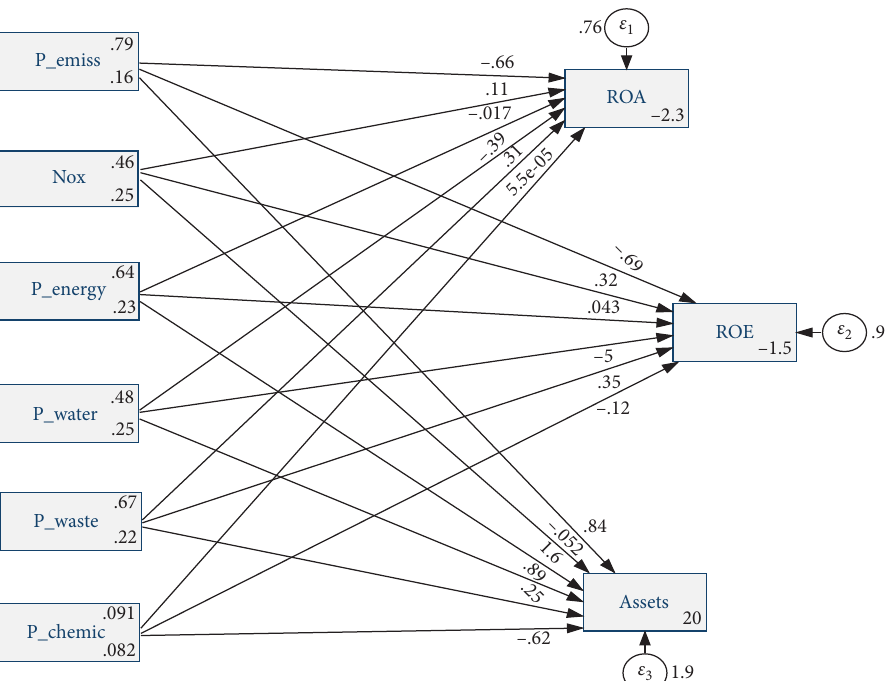
Figure 2: The association between policy measures and the financial performance (SEM-LCA), for oil and gas companies from the EEA, 2009–2018. Source: own contribution in Stata 16.